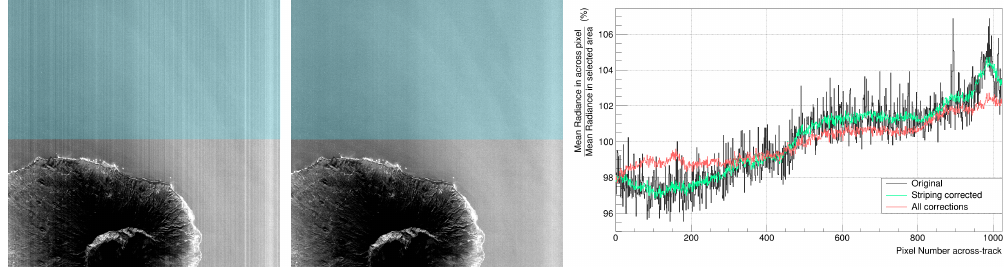
Figure 2. Correction of striping in DESIS Images: ( left ) original image band 16, with visible stripes (image stretched to emphasize the stripes); ( middle ) the same image after striping correction (same stretching); and ( right ) the relative variation of radiance across-track, averaged along-track over the colored area above the island. Colors in the right plot indicate the original image data (black), striping-corrected data (green) and data corrected by striping, flat-fielding and spectral-adjustment using the current DESIS calibration